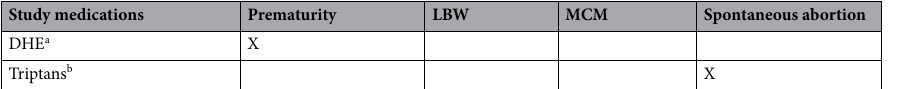
Table 11. Summary of statistically significant study findings. a Dihydroergotamine; b Including